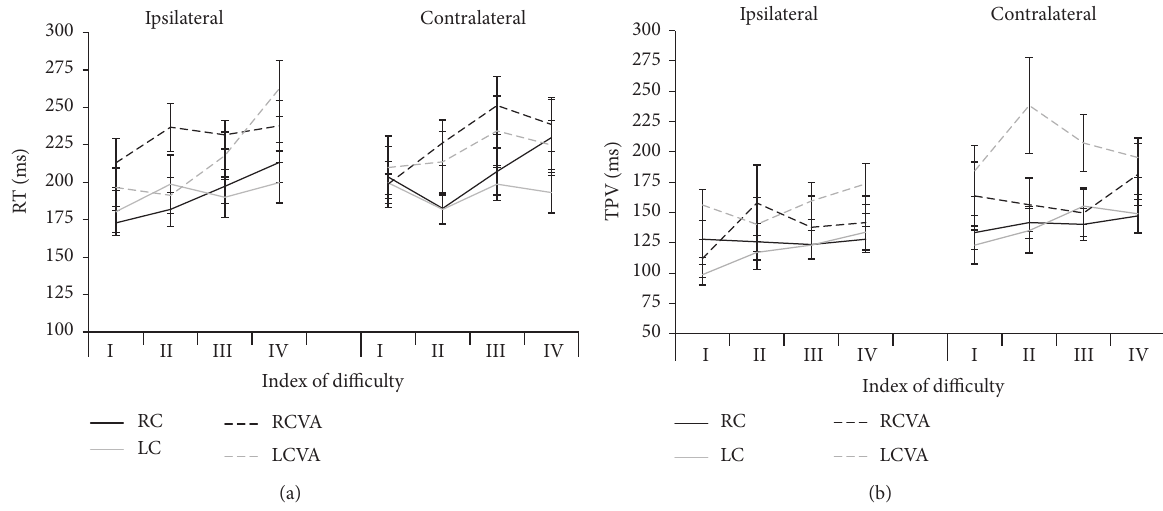
Figure 3: Mean reaction time (a) and mean time to peak of velocity (b) for the right (RC) and left (LC) arms of control group and ipsilesional arms of participants with right (RCVA) and left (LCVA) cerebrovascular accident for ipsilateral and contralateral movements for each index of difficulty ( I = 3.5; II = 4.5; III = 4.5; IV = 5.5) . Bars indicate standard error.